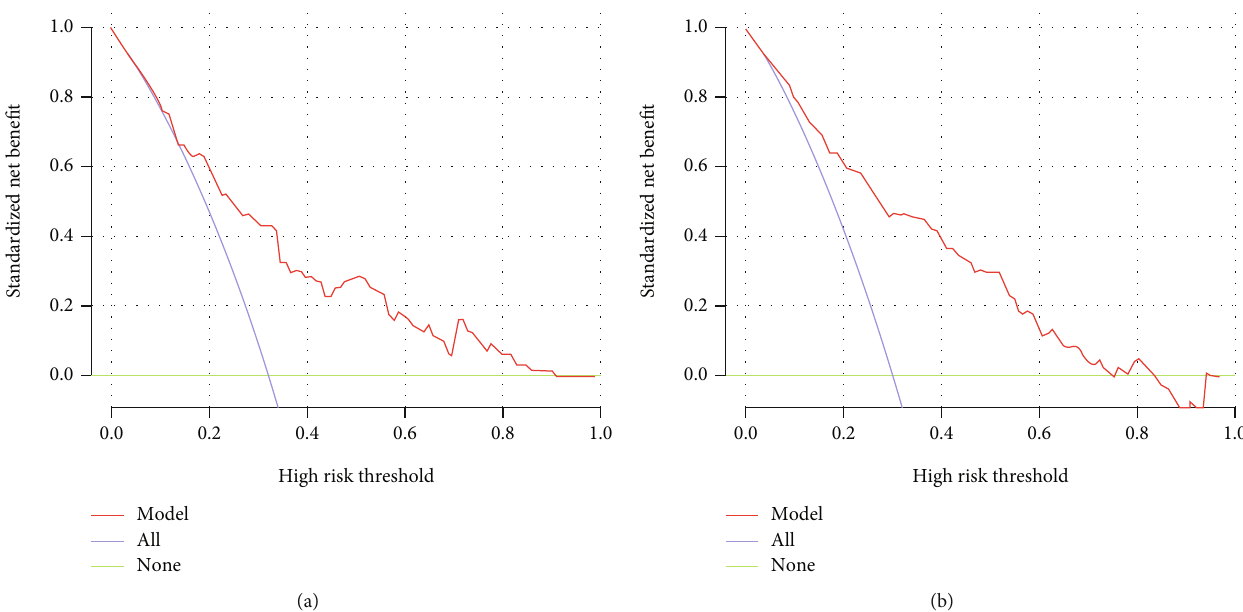
Figure 5: The clinical bene fi t of the predictive model was evaluated with data from the training set (5A) and the validation set